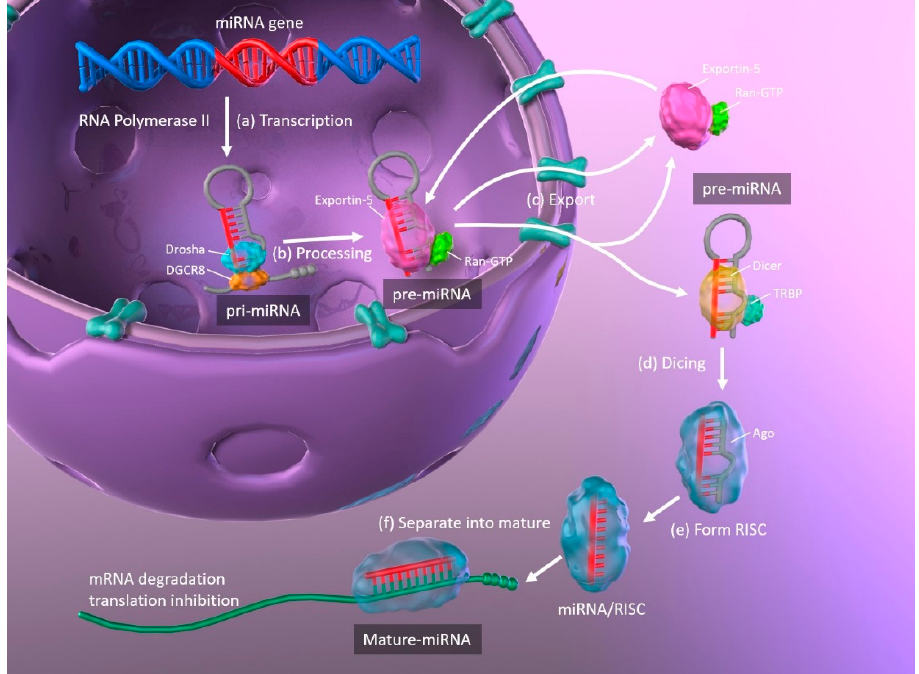
Figure 1. Schematic representation of miRNA biogenesis. ( a ) Synthesis of pri-miRNA transcripts from DNA. ( b ) pri-miRNA is processed by Drosha and DGCR8, resulting in a hairpin intermediate pre-miRNA. ( c ) Exportin-5 and Ran-GTP bind to pre-miRNA, and the complex is exported from the nucleus to the cytoplasm. ( d ) The hairpin pre-miRNA is cleaved by Dicer and TRBP. ( e ) The double-stranded miRNA is unwound and forms RISC with Ago. ( f ) The miRNA separates into mature, single-stranded miRNA. miRNA: microRNA; pri-miRNA: primary microRNA; DGCR8: DiGeorge syndrome critical region 8; TRBP: transactivation response element RNA-binding protein; RISC: RNA-induced silencing complex; Ago: argonaute.